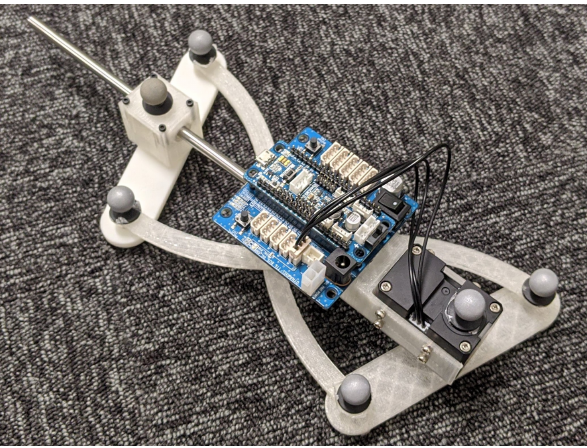
Figure 18. The installation locations of the markers. The six markers were installed on O r , O (cid:48) r , P 1 , P 2 , P 3 , and P 4 of the